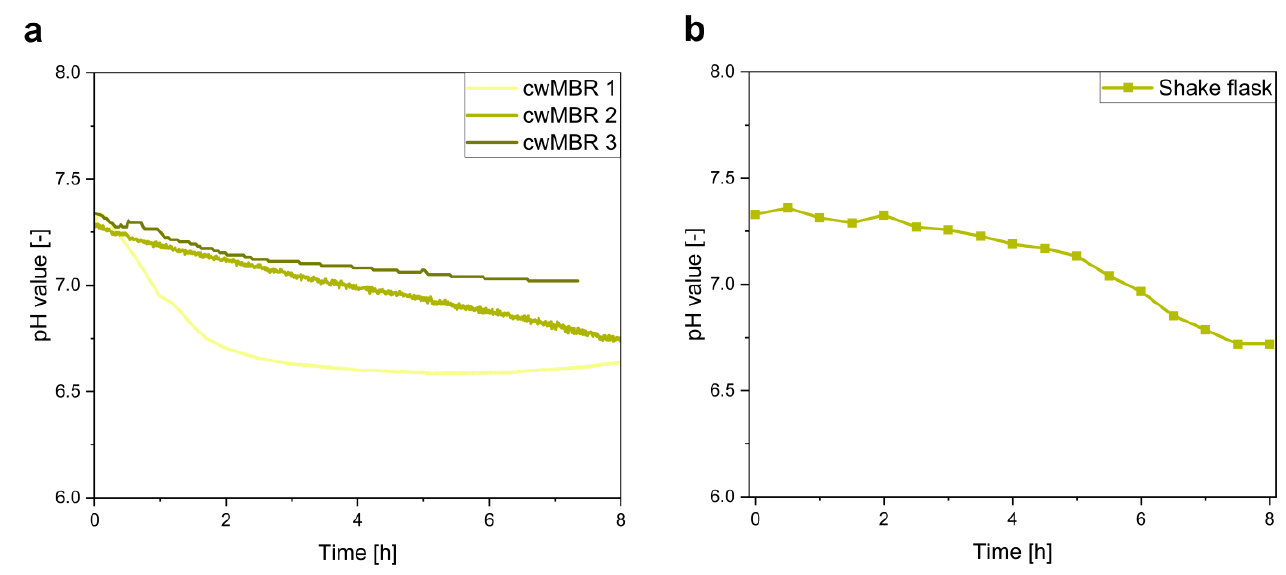
Figure 8. ( a ) pH values of an E. coli cultivation in M9 minimal medium in three parallel cwMBRs, showing a pH decrease due to the production of acidic by-products in all cwMBRs. Vertical oscillation of the cwMBR was performed at 70 Hz and an amplitude of 5%. pH was measured by optical sensors on the bottom of the cwMBR; ( b ) pH value of a cultivation of E. coli in shake flasks with M9 medium measured by a pH electrode. The graph shows the mean of triplicates.